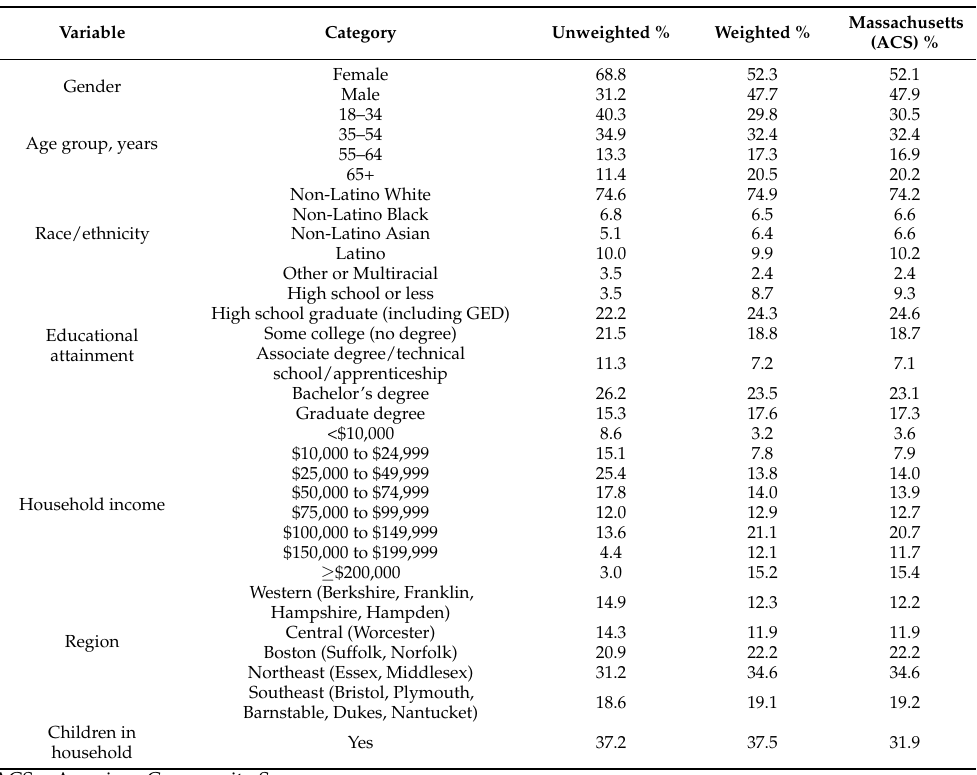
ACS = American Community